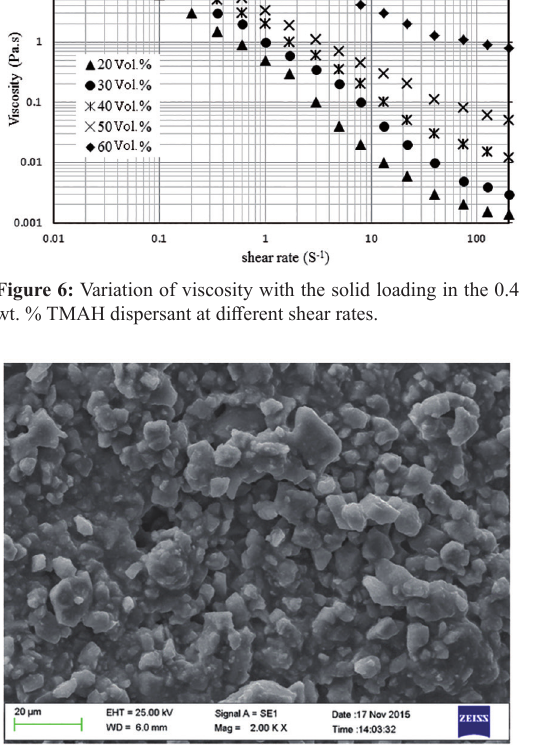
Figure 7: SEM micrograph of fracture surface of TiC green body gelcasted with 0.4 wt. %